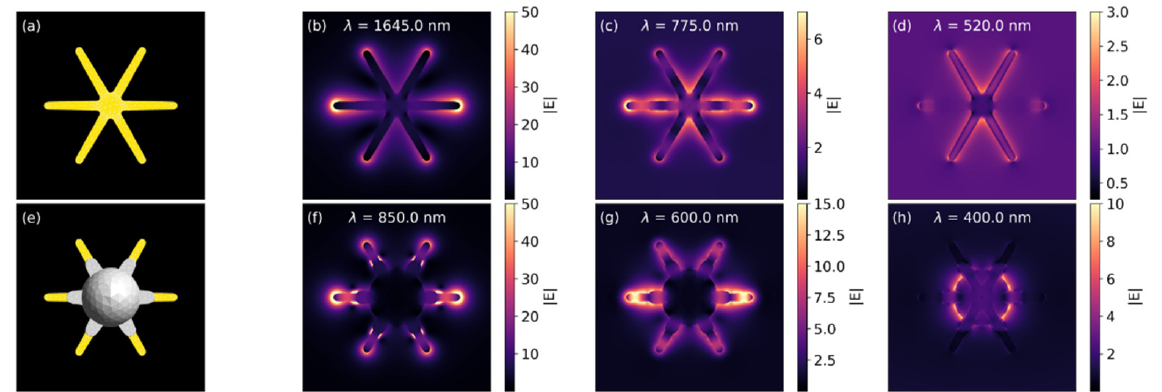
Figure 4. Local field enhancement maps for a pristine GNS and a R shell = 30 nm GNS@Ag. The field is mapped over a square of side 200 nm at the GNS equatorial plane: ( a , e ) Sketch of the modelled structures; ( b , f ) local field map of the main dipolar resonance at λ = 1645 nm and λ = 850 nm; ( c , g ) local field map of the second order resonance at λ = 775 nm and λ = 600 nm; ( d , h ) local field map of the gold core and silver shell resonance at λ = 520 nm and λ = 400 nm.